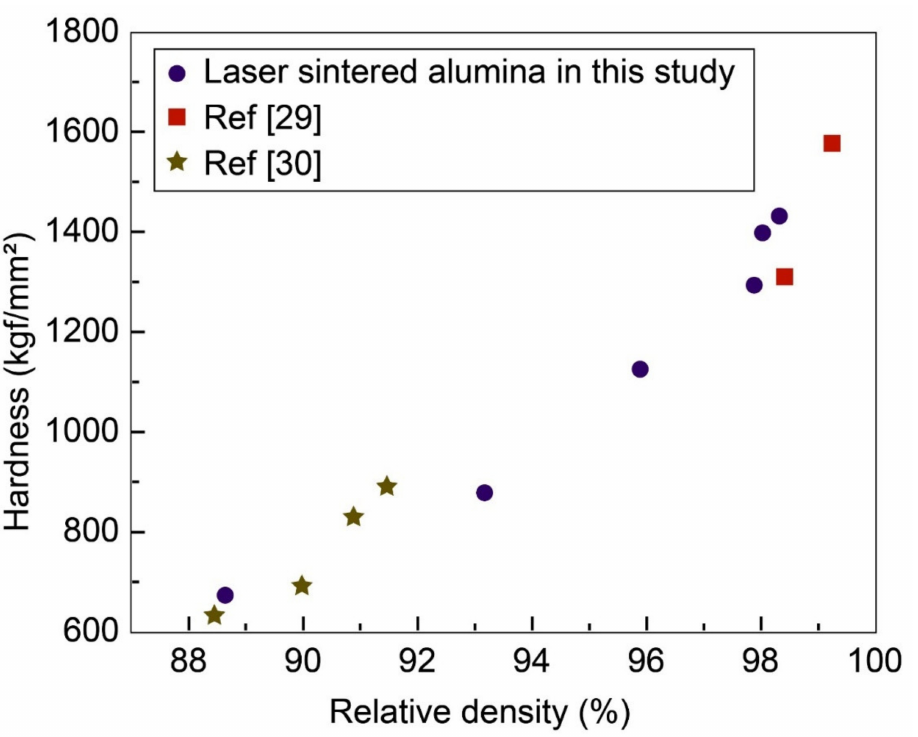
Figure 9. The correlation between the relative density and hardness of laser-sintered alumina sample